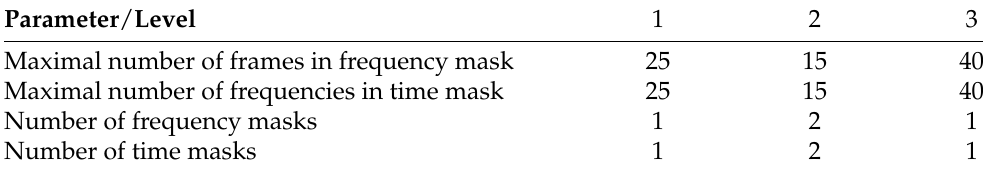
Table 6. Hyperparameter values for the used SpecAugment levels.